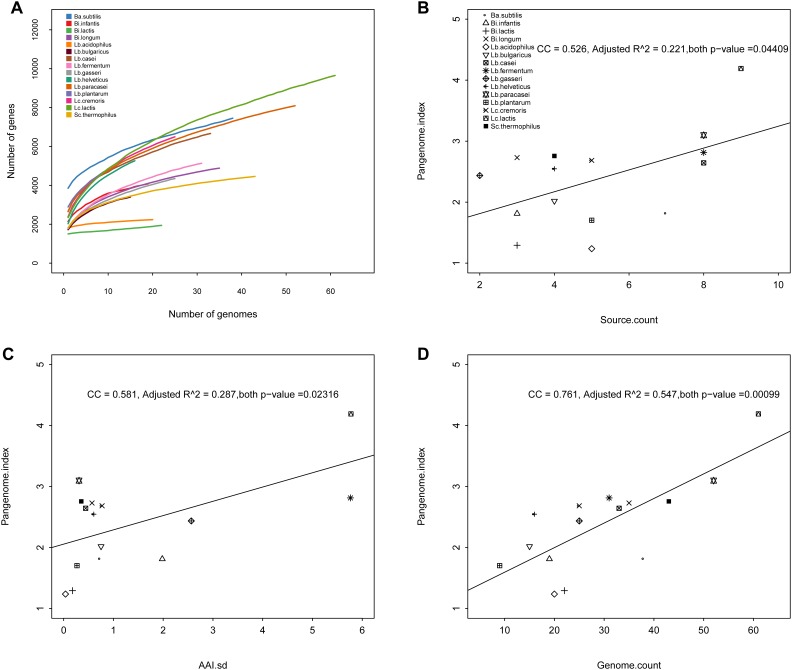
Pan-genome rarefaction and pan-genome index. (A) The pan-genome rarefaction curve of 15 species. (B) Correlation between pan-genome index and source count of each species, CC: correlation coefficient. (C) Correlation between pan-genome index and intra-species amino acid identity (AAI) SD. (D) Correlation between pan-genome index and genome count of each species.